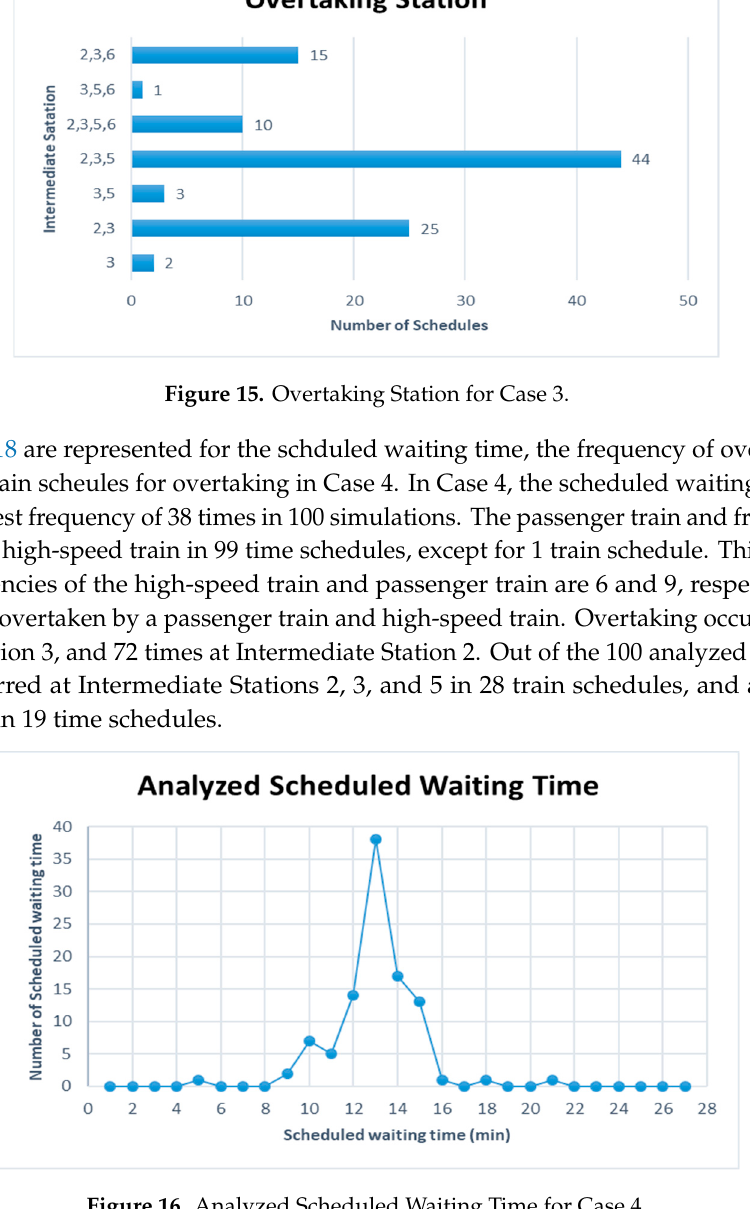
Figure 16. Analyzed Scheduled Waiting Time for Case 4.